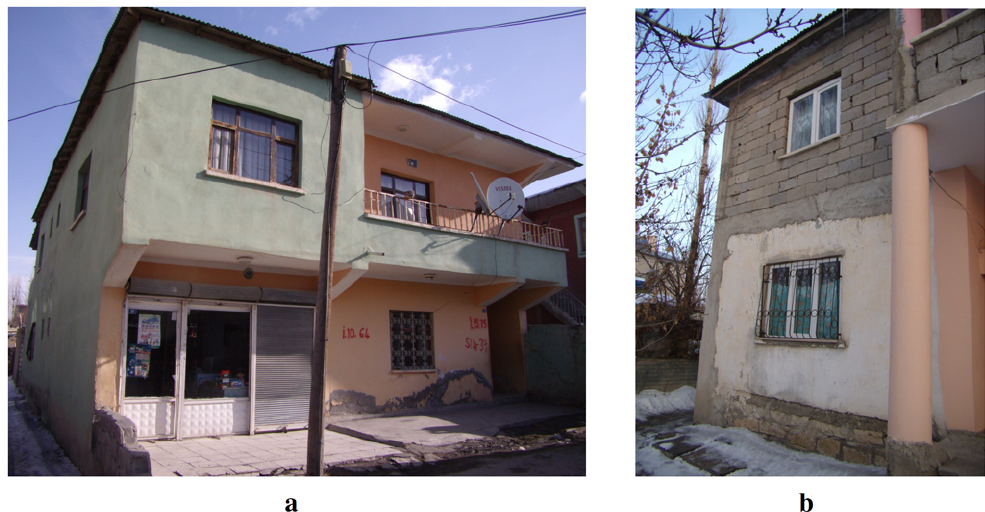
Fig. 24. Views of typical confined masonry